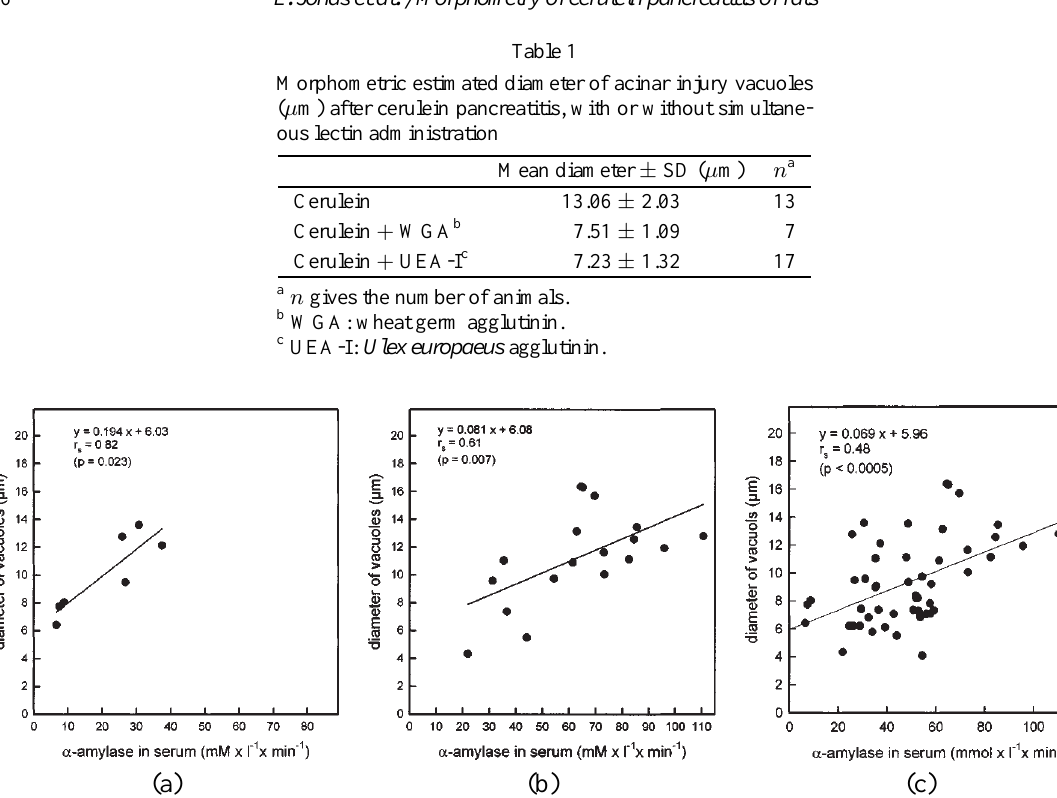
Fig. 5. Correlation between (cid:11) -amylase activity in the serum (mmol/l (cid:2) min) and morphometric estimated diameter of acinar injury vacuoles ( (cid:22) m); (a) regression line after iv medication of only cerulein through a jugularis catheter, n = 7; (b) regression line after ip medication of only cerulein, n = 18; (c) regression line after iv or ip medication of cerulein with or without simultaneous administration of WGA or UEA-I, n =